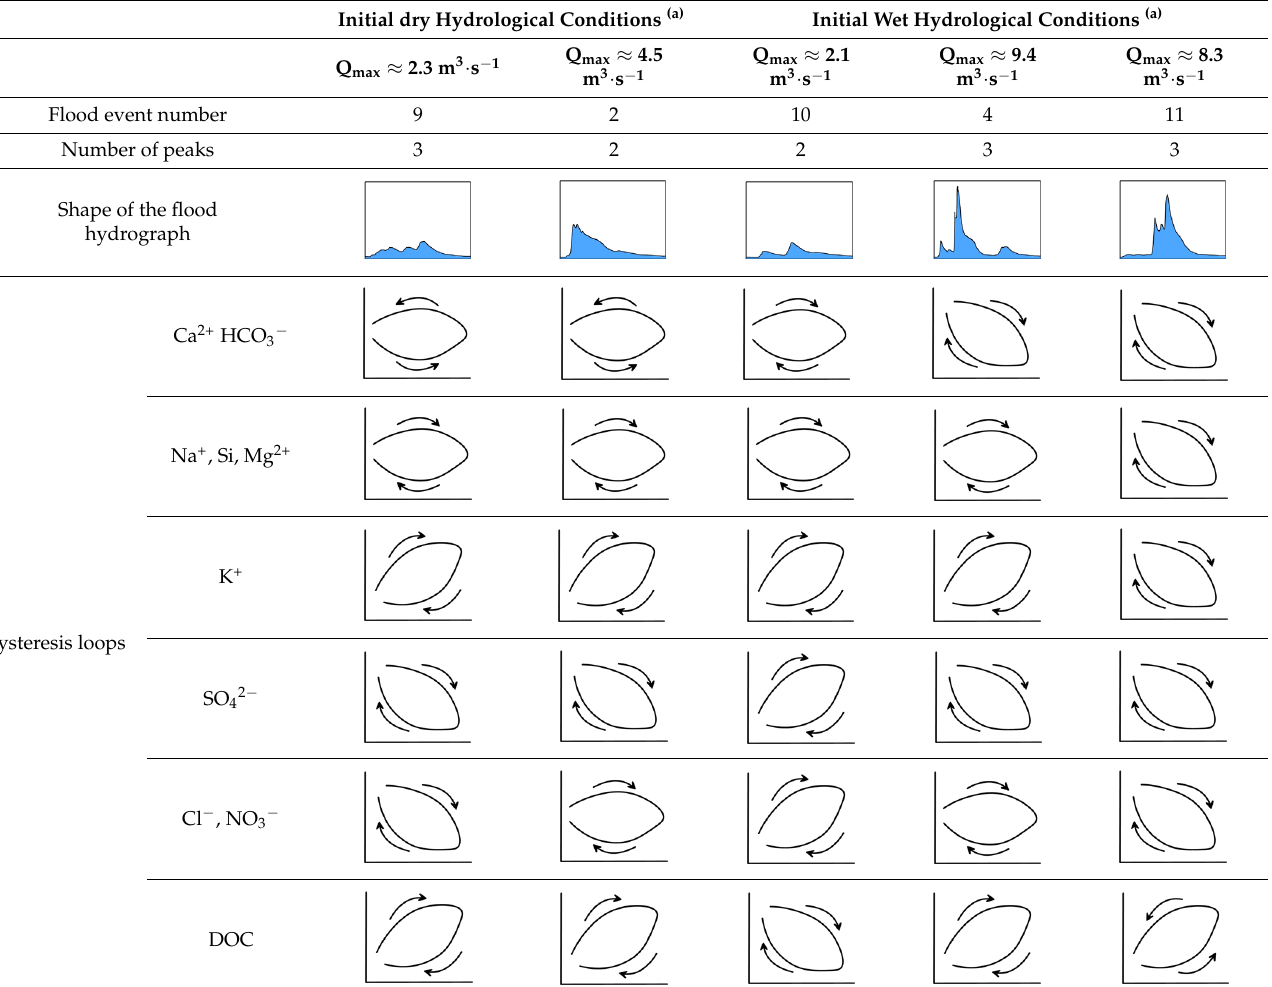
Table 3. Summary of the main C-Q responses in BC according to distinct hydrological conditions. The schematic representation of the hysteresis loop corresponds to the C-Q behavior during the major peak.